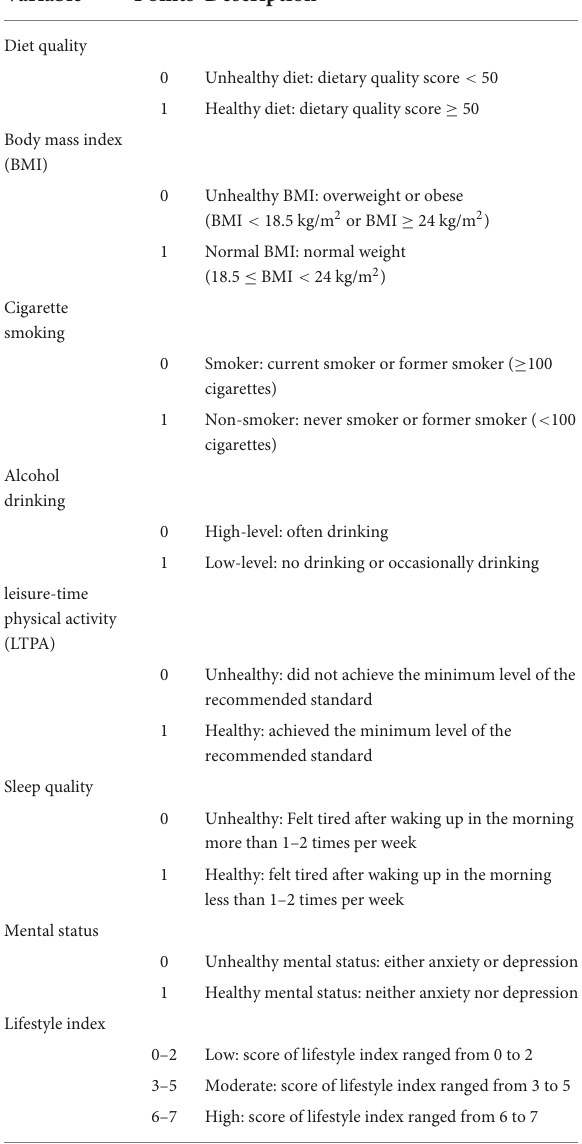
TABLE 1 The definition of the healthy lifestyle